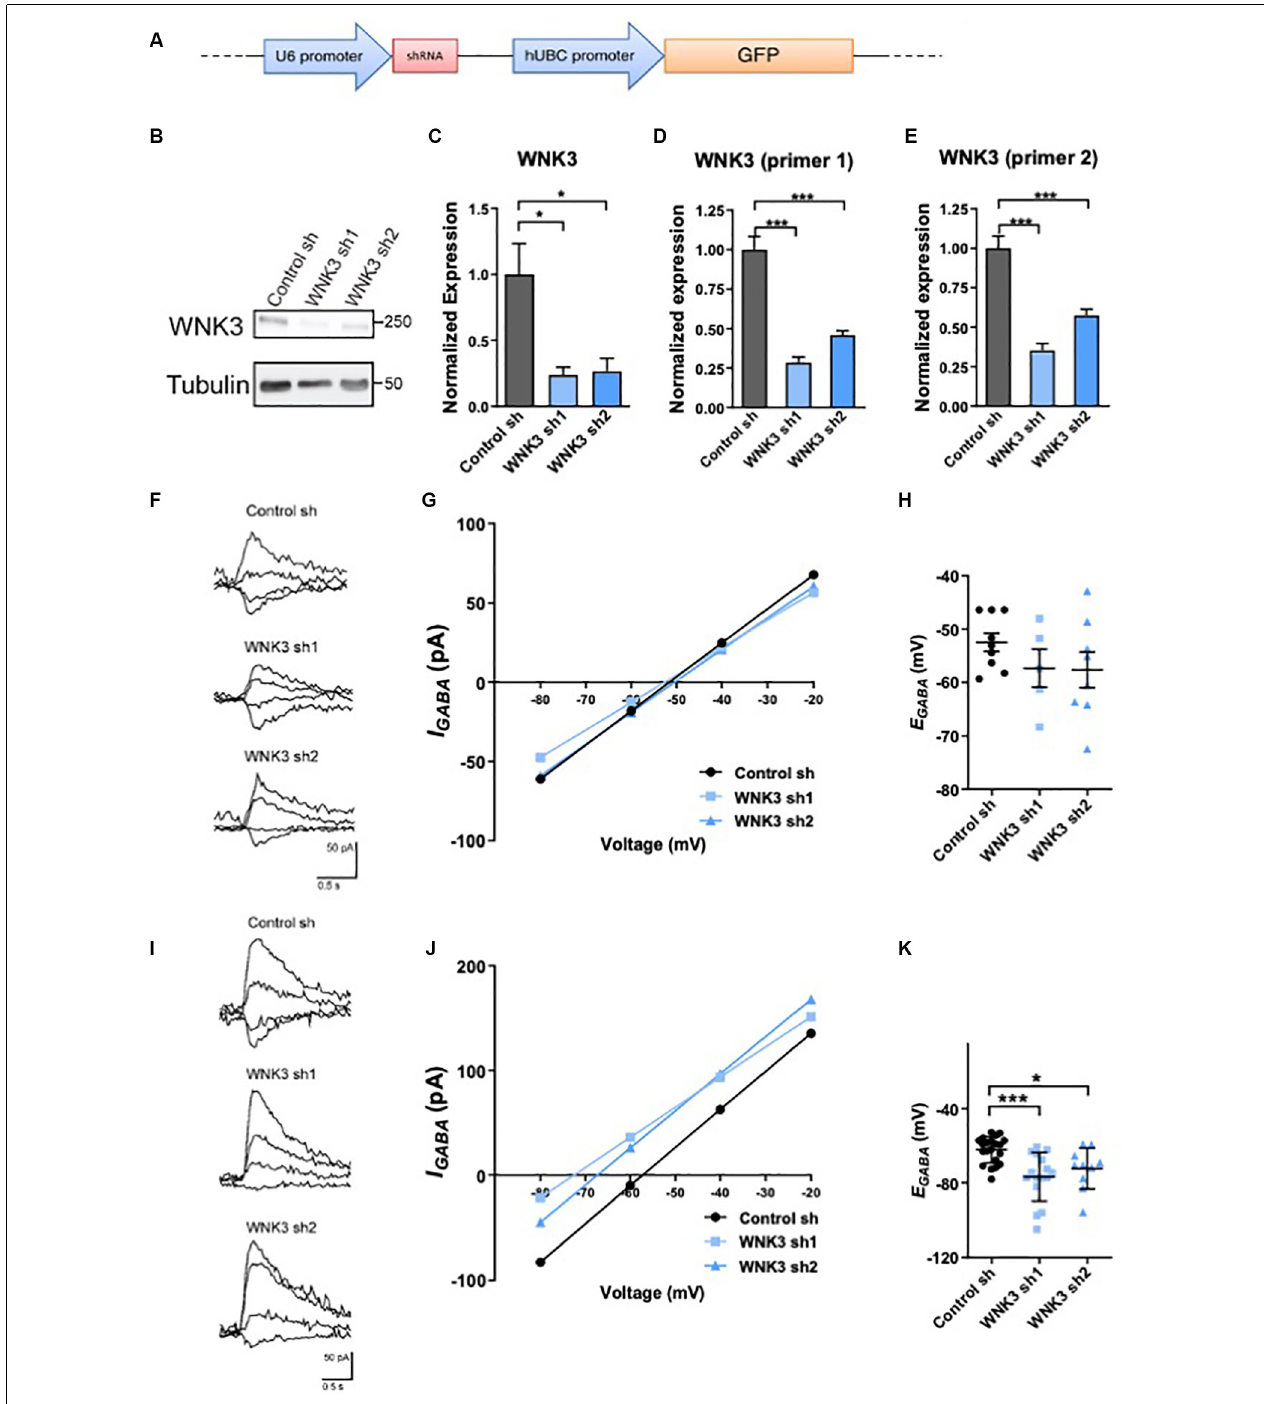
FIGURE 2 | Regulation of WNK3 on E GABA in immature and developed neurons. (A) The schematic diagram for FUGW lentiviral constructs carrying both a GFP reporter gene driven by human ubiquitin-C promoter, and a control short hairpin RNA (shRNA) driven by U6 promoter. (B) Representative Western blots showing the expression of WNK3 in WNK3 sh1 and sh2 neurons at DIV7. (C) Quantification of WNK3 protein expression from (B) . (D,E) Relative expression of WNK3 primer1 and primer2 mRNA in WNK3 sh1 and sh2 neurons at DIV7, protein, and mRNA expression levels were normalized to their respective loading controls and expressed relative to control sh levels. n = 3 cultures. * p < 0.05 and *** p < 0.001. One-way ANOVA with Bonferroni post-hoc . (F) Relative image of GABA-evoked current of control, WNK3 sh1, and sh2 neurons at DIV6–8. (G) Representative currents recorded in gramicidin perforated-patch configuration during incremental voltage steps and corresponding current-potential curves in control and WNK3 sh neurons at DIV6–8. E GABA is interpolated from the four points around